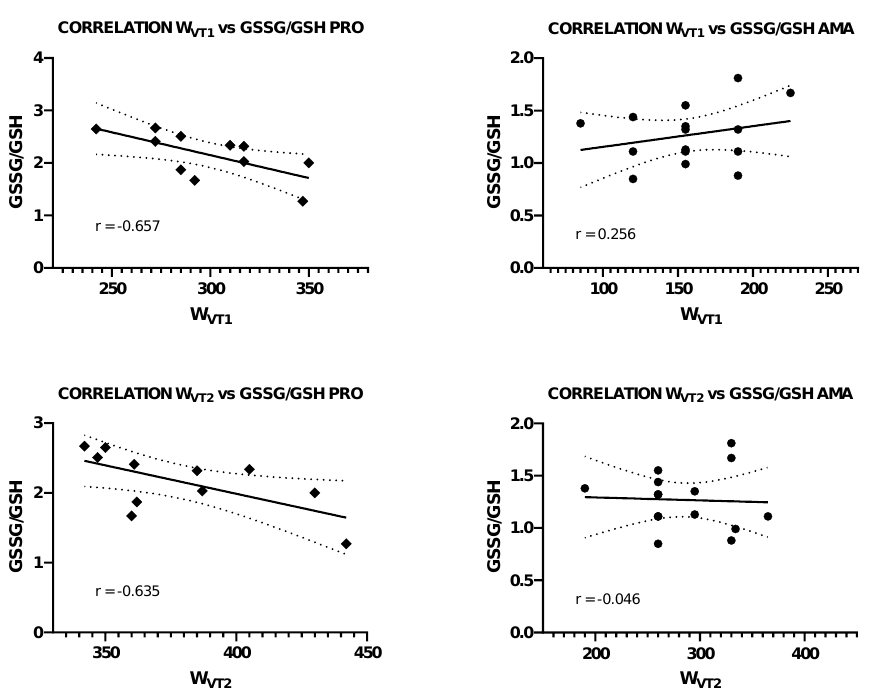
Figure 1. Correlations between the power generated at the ventilation threshold 1 and 2 between the GSSS/GSH ratio in PRO and AMA. Table 4. Correlation between endogenous antioxidant enzymes and performance-metabolic varia- bles from professional and amateur cyclists.